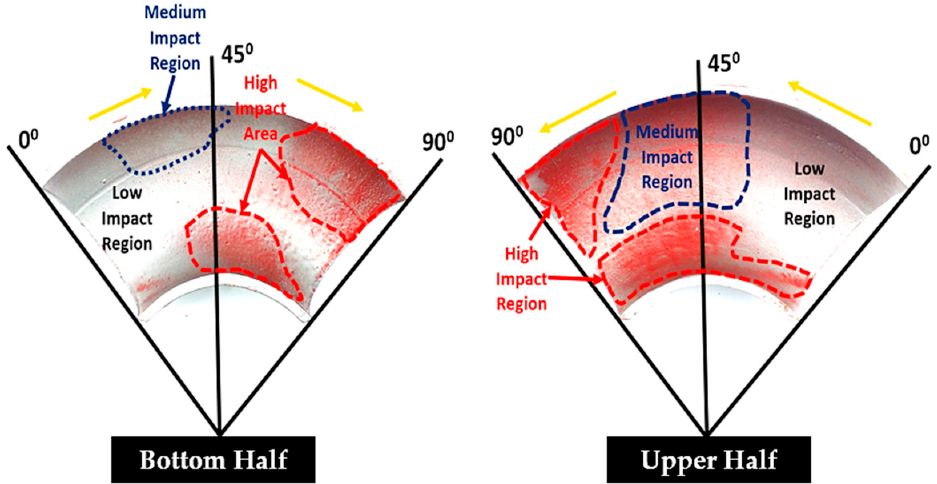
Figure 6. Erosion pattern on the 90° elbow coated with a two-layer paint.